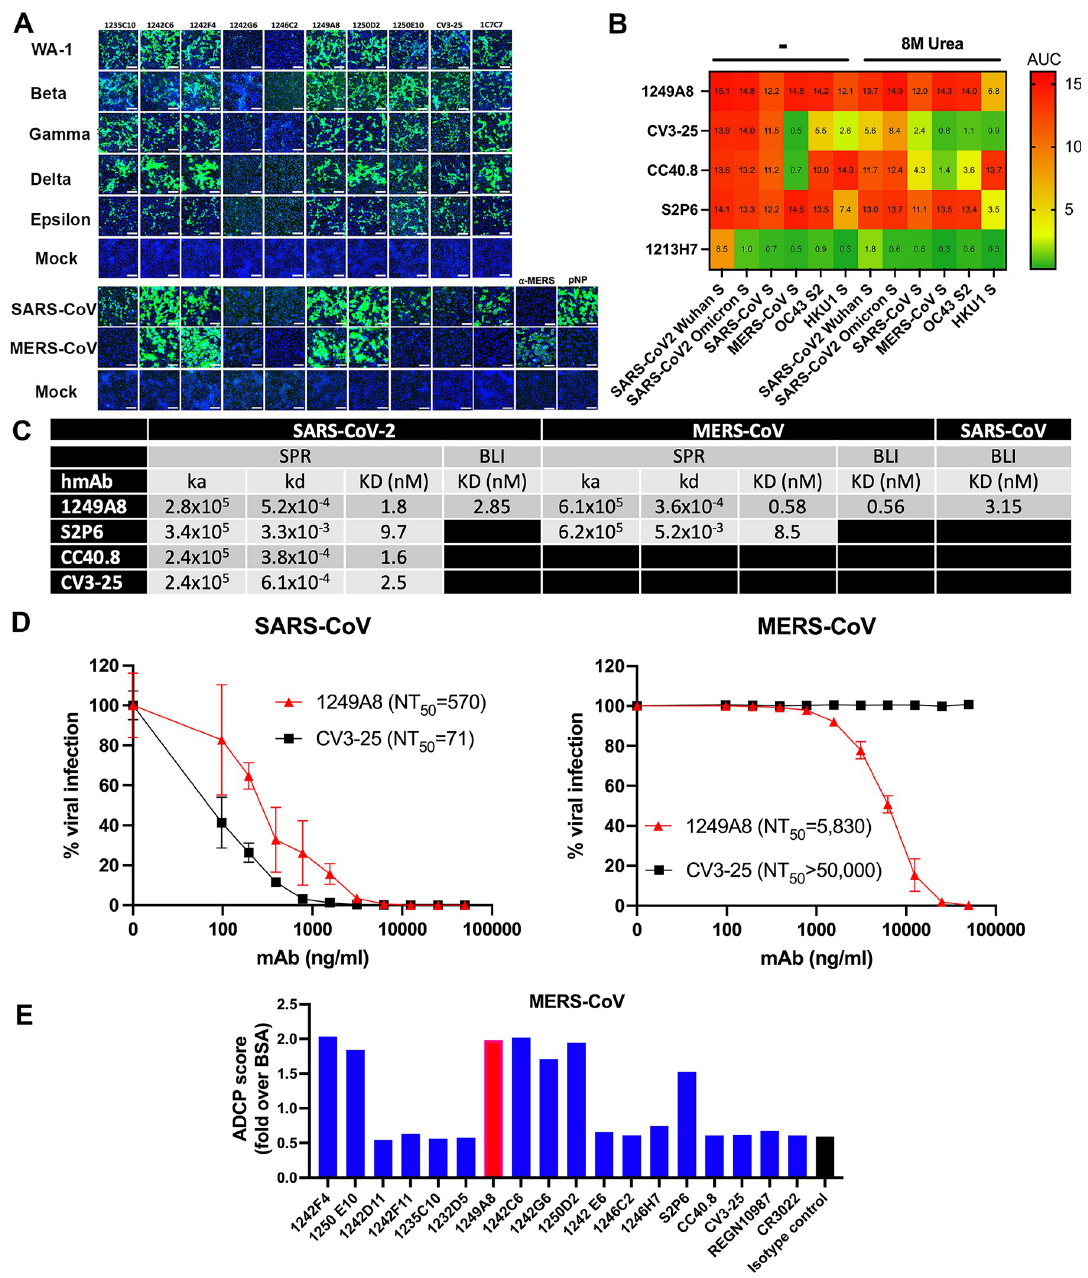
Fig 4. Universal β -coronavirus in vitro activity of 1249A8 hmAb. ( A ) Confluent monolayers of Vero E6 cells were infected (MOI 0.1) with SARS-CoV-2 WA-1, Beta (B.1.351), Gamma (P.1), or Epsilon (B.1.427/B.1.429). Mock-infected cells (bottom) were included as control. In a separate experiment, confluent monolayers of Vero E6 cells were infected (MOI 0.1) with SARS-CoV (Urbani v2163) or MERS-CoV (recombinant MERS-CoV-RFP delta ORF5 ic). Cells were incubated with the indicated primary S2 hmAb (1 μ g/ml) and developed with a FITC-conjugated secondary anti-human Ab. 4,6-Diamidino-2-phenylindole (DAPI; blue) was used for nuclear stain. As internal control, mock and SARS-CoV-2 WA-1 infected cells were stained with a SARS-CoV cross-reactive NP mAb (1C7C7) or a -MERS NP pAb. Scale bars indicate 50 μ m. ( B ) Binding of hmAb 1249A8 and other known S2-specific mAbs at 5, 0.5, and 0.05 μ g/ml to the Spike proteins of β -coronaviruses as determined by ELISA in the presence or absence of 8M urea. ( C ) Summary table of Surface Plasmon Resonance (SPR) and Biolayer Interferometry (BLI) of 1249A8 against the Spike protein of SARS-CoV-2, MERS-CoV, and SARS-CoV. ( D ) Viral neutralization by 1249A8 and CV3-25. Vero E6 cells were infected with 100 PFU of SARS-CoV (Urbani v2163) or MERS-CoV (recombinant MERS-CoV-RFP delta ORF5 ic) for 1 h. After 1 h of viral adsorption, the indicated concentrations of S2 hmAbs were added. At 24 h.p.i., infected cells were fixed for virus titration by immunostaining assay. ( E ) ADCP of S2-specific mAb against MERS-CoV Spike coated